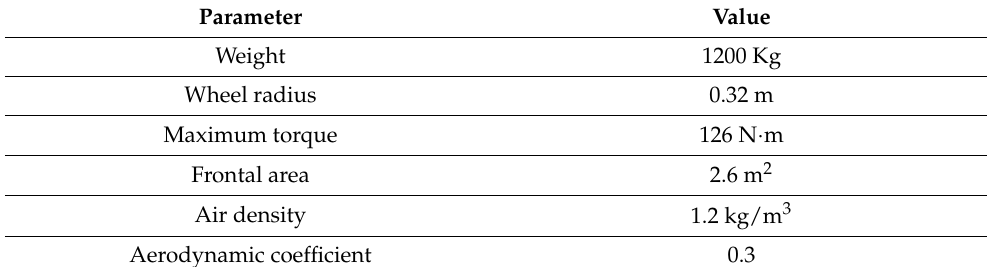
Table 4. Used HEV